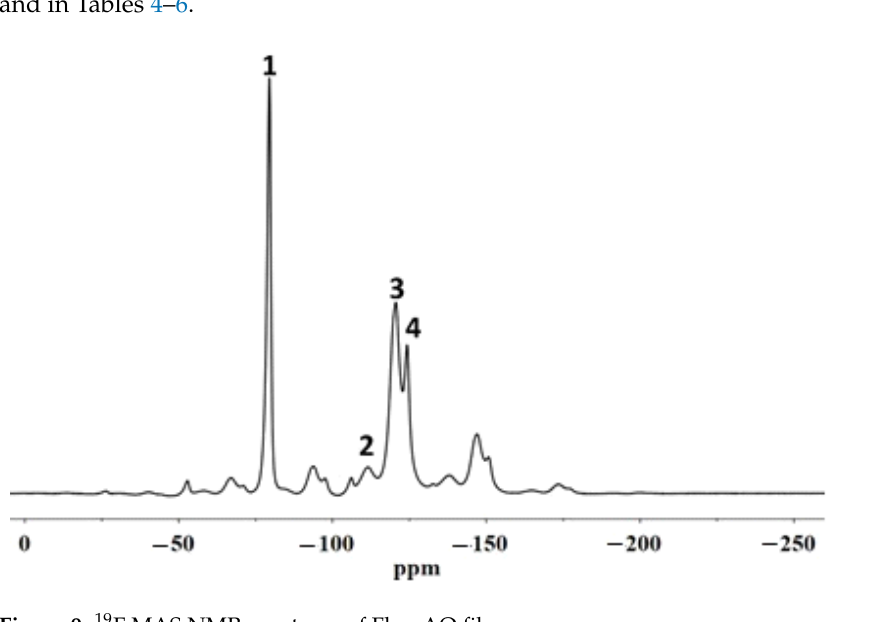
Figure 10. 13 C{ 19 F} CP − MAS NMR spectrum of Fluo AQ film. Table 5. Assignment of the chemical shift of 13 C{ 19 F} CP-MAS. Peak